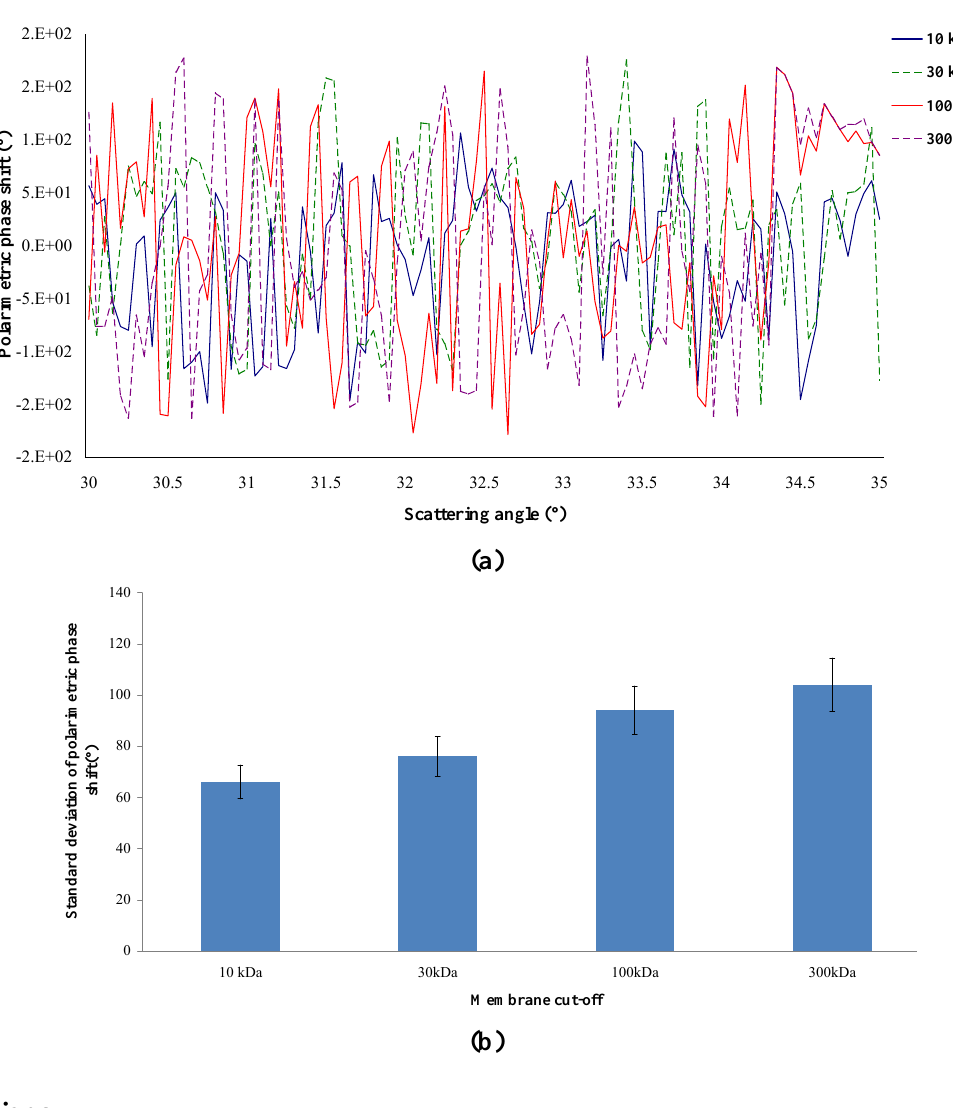
Figure 3. Polarimetric phase shift (a) and standard deviation of the polarimetric phase shift (b) as a function of the scattering